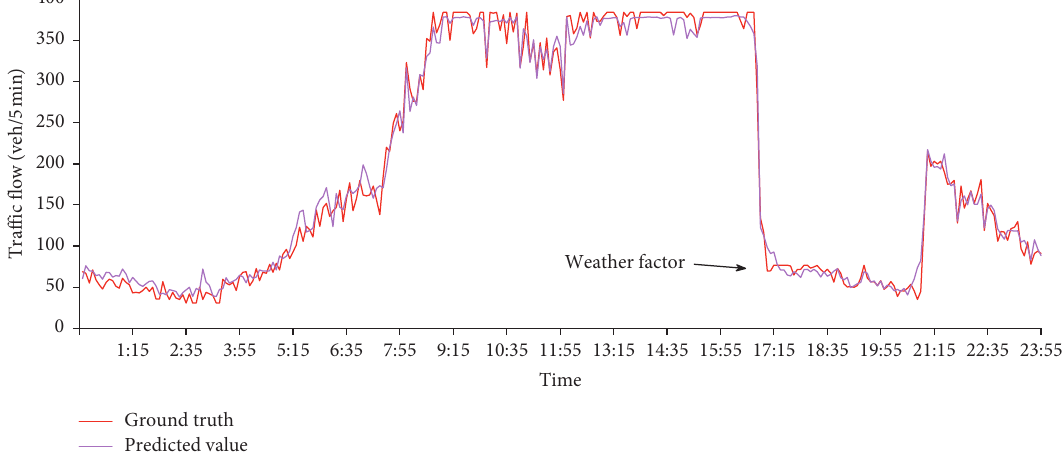
Figure 12: Special sample (weather factor) traffic flow prediction results of the XGBoost-I-lag method.